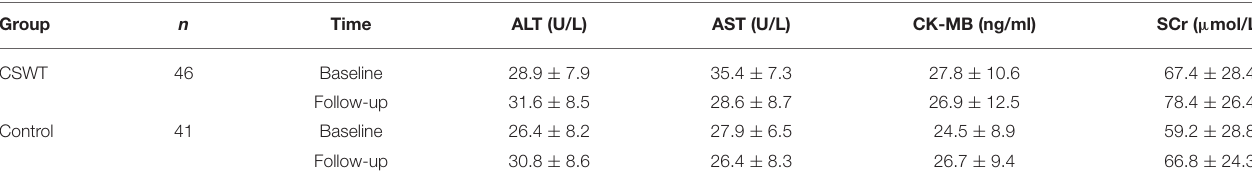
Frontiers in Cardiovascular Medicine |